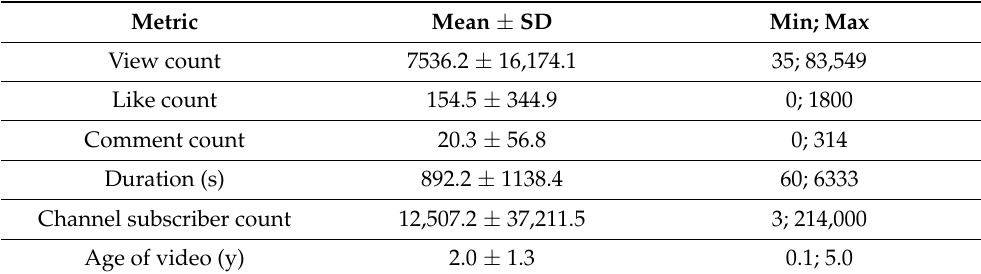
Table 1. Viewing metrics of the 38 videos.